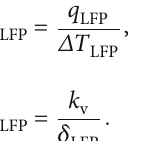
for class I. LFP